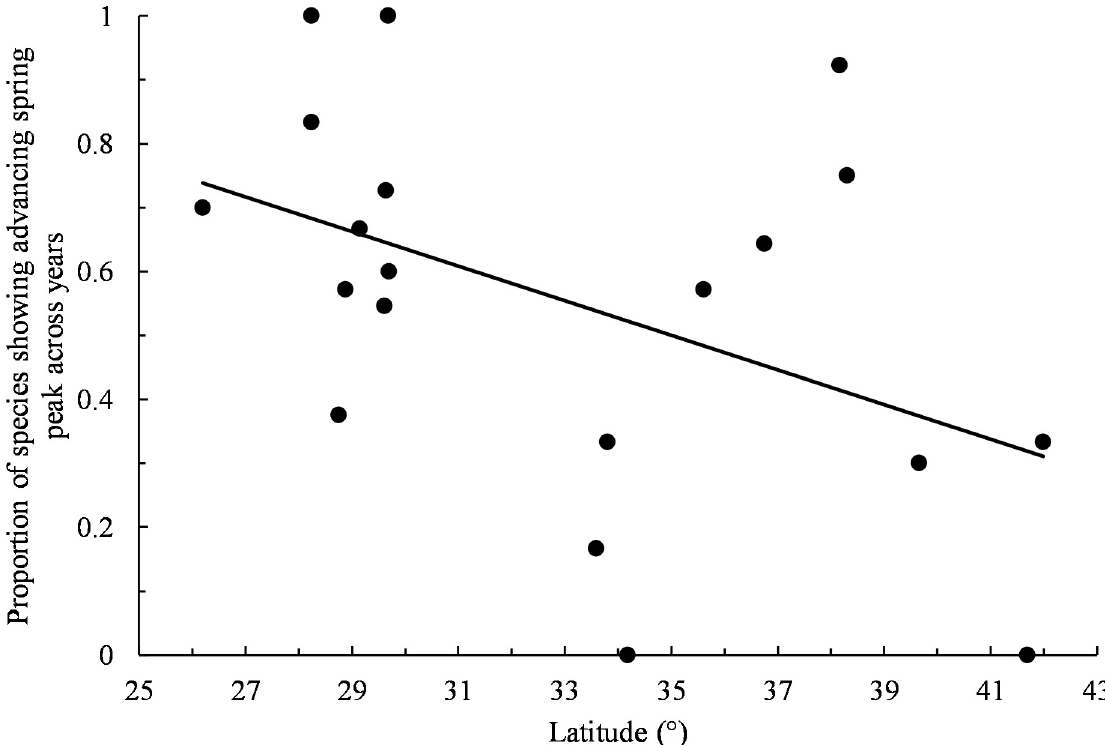
Fig 2. Proportion of species showing advancing spring peak across years by refuge latitude. Only non-zero slopes were included. Trend line obtained by least squares linear